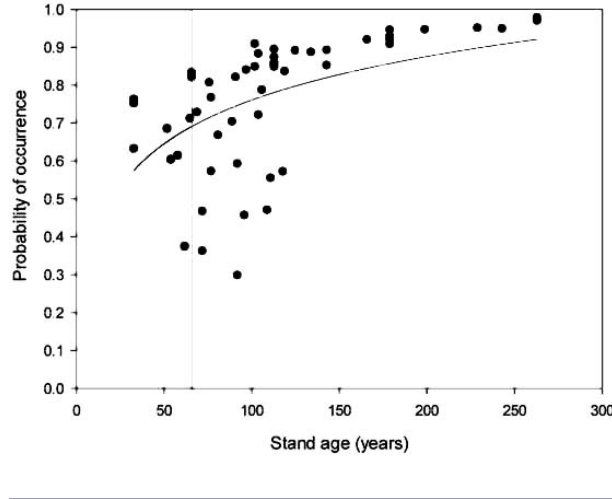
Fig. 9 . Relationship between stand age and the probability of occurrence of Blackburnian Warbler in pine forests. Threshold derived from ROC curve is shown as vertical line (see